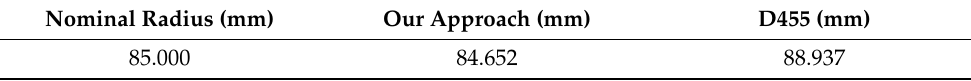
Table 6. The measured radius of our approach and D455.